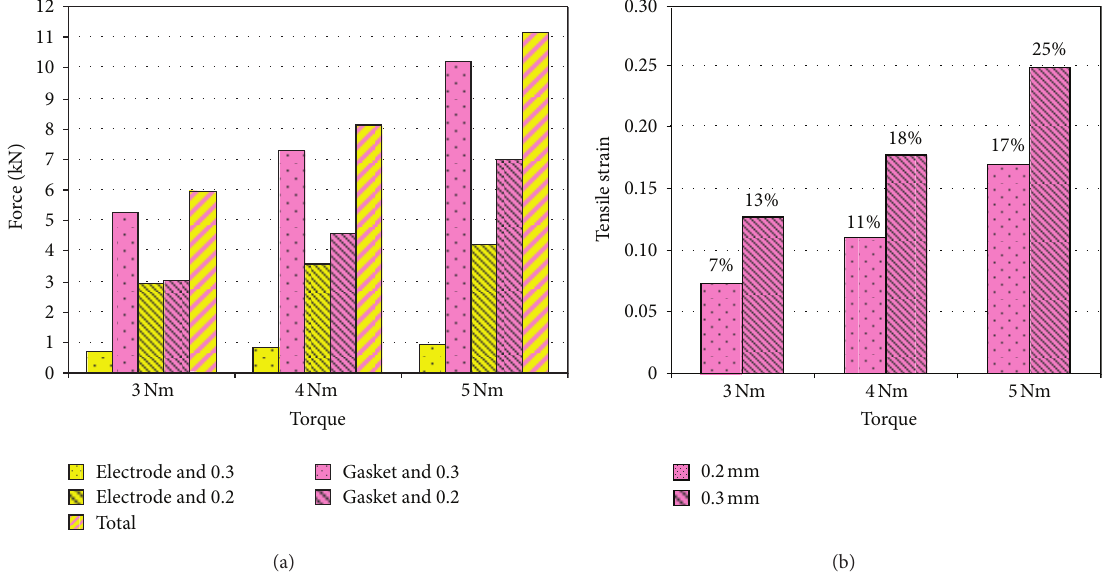
Figure 7: (a) Clamping force and (b) tensile strain of the PTFE gasket under different